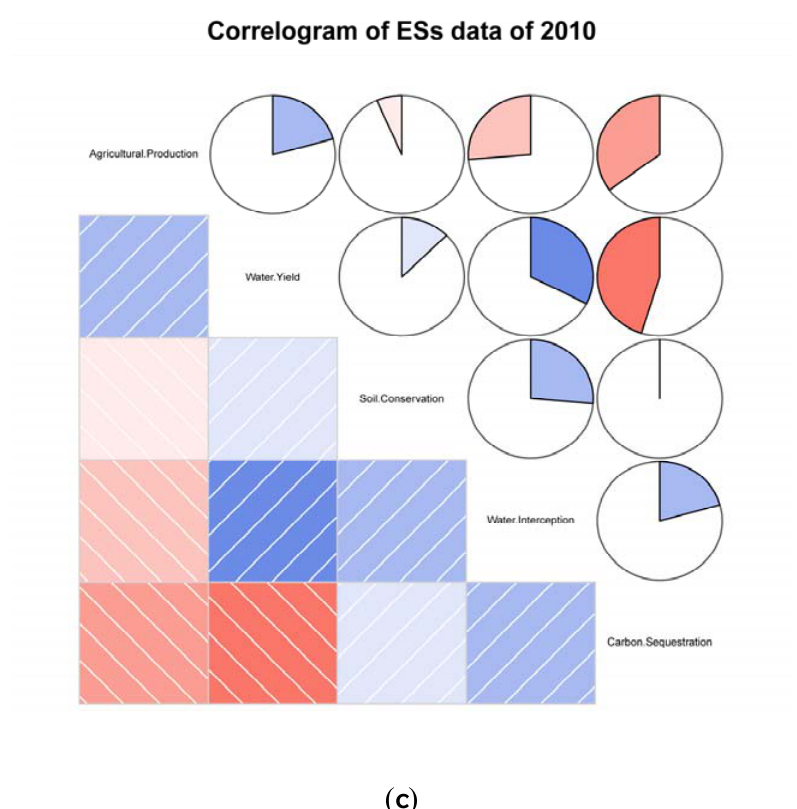
Figure 5. Correlograms of ecosystem services. In the above plot, the directions of slashes in the lower panel divide relationships into two categories, positive and negative. Also, blue denotes positive relationships while pink denotes negative relationships. The darker the colors and the bigger the painted areas are, the stronger the relationships between data. Color covering the whole right pie means the correlation coefficient equals to 1. And an empty pie means 0 correlation coefficient. ( a ) for year 2000, ( b ) for year 2005 and ( c ) for year